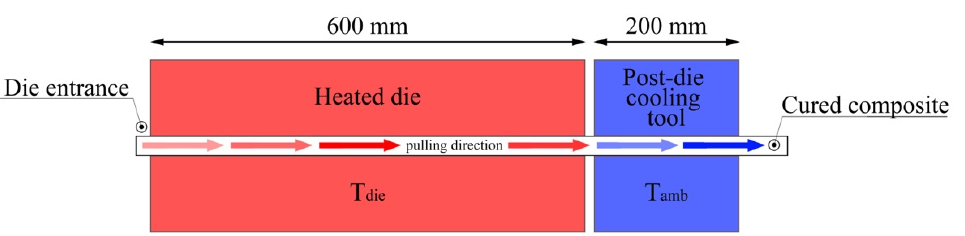
Figure 3. Geometry and position of the heated die and post-die cooling tool.